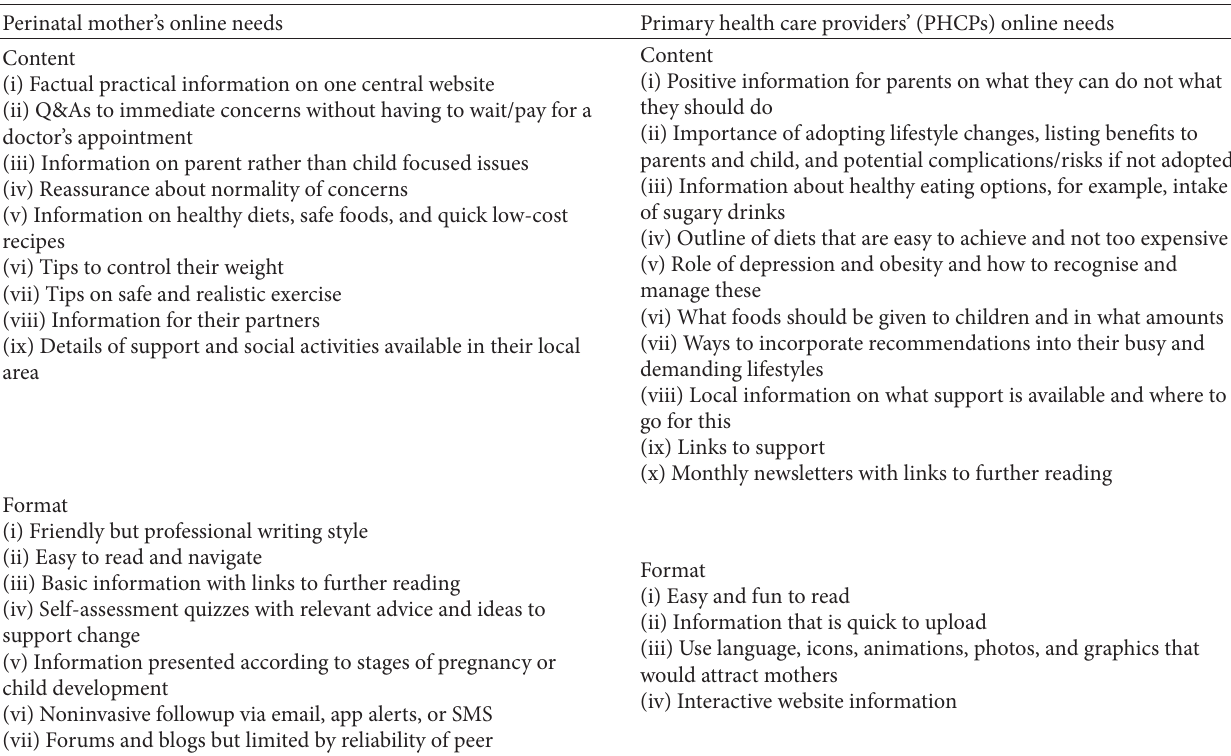
Table 1: Perinatal women and PHCP online needs and preferences for health lifestyle information. Perinatal mother’s online